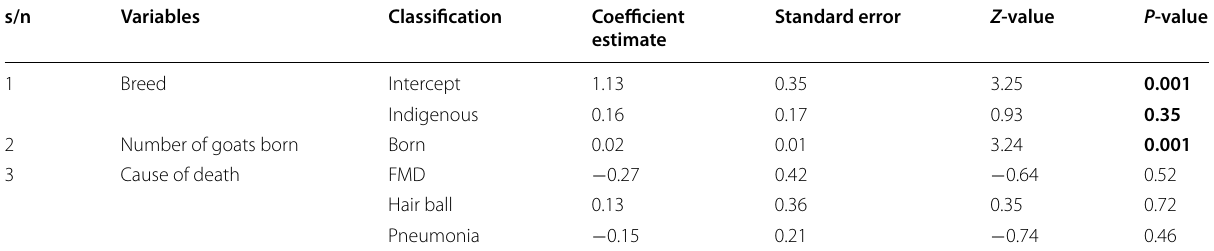
Table 4 Association between the mortality rate with the breed of goat, number of individuals born, and causes of death s/n